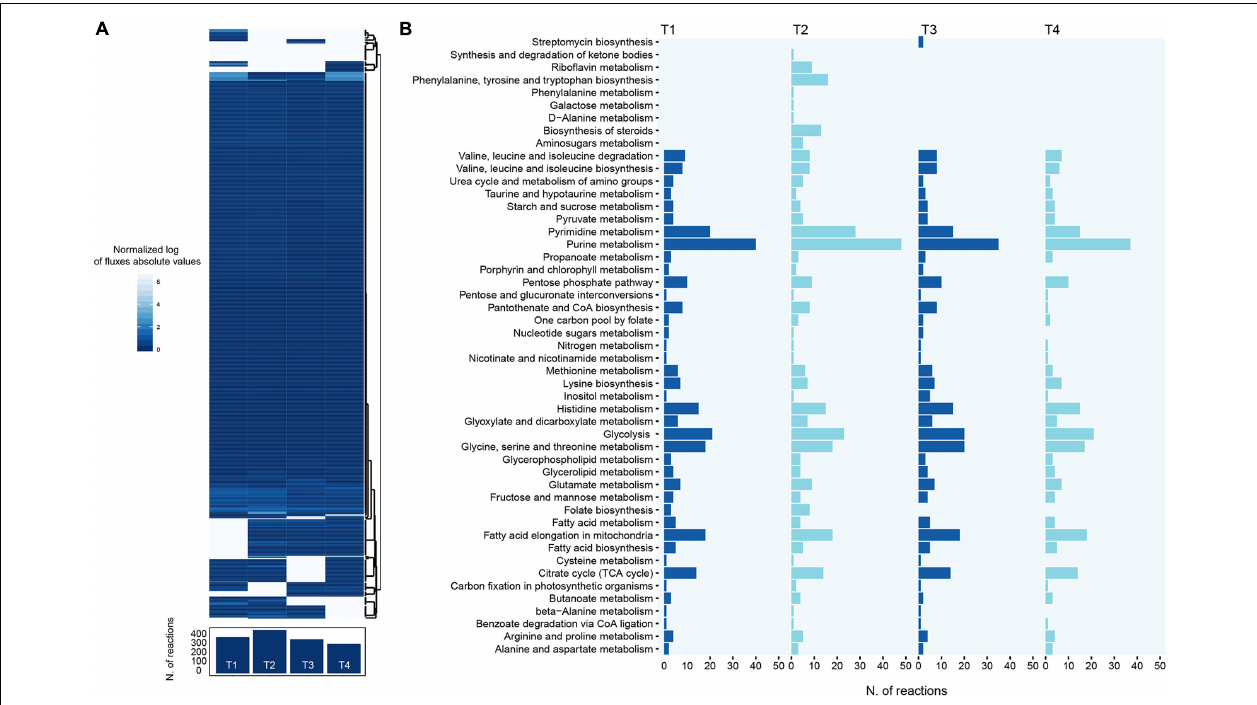
FIGURE 4 | Distribution of metabolic fluxes. (A) Heatmap showing the predicted flux carried by each reaction in the model across each of the time points. Also, the number of flux-carrying reactions for each point is shown. (B) The number of active reactions (i.e., reactions predicted to carry flux) is reported for the major pathways in the reconstruction, for each of the four time points